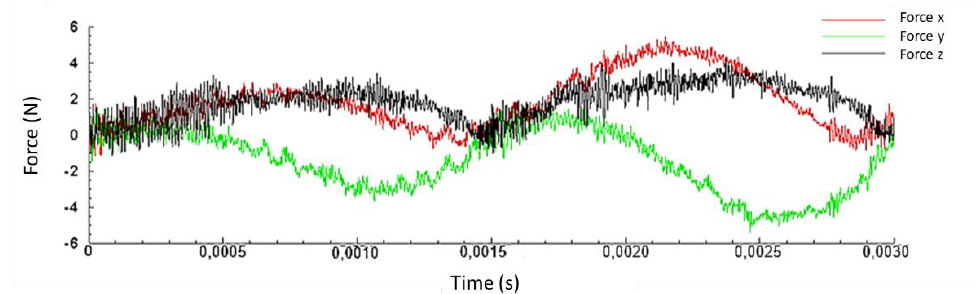
Figure 5: Computational results for cutting